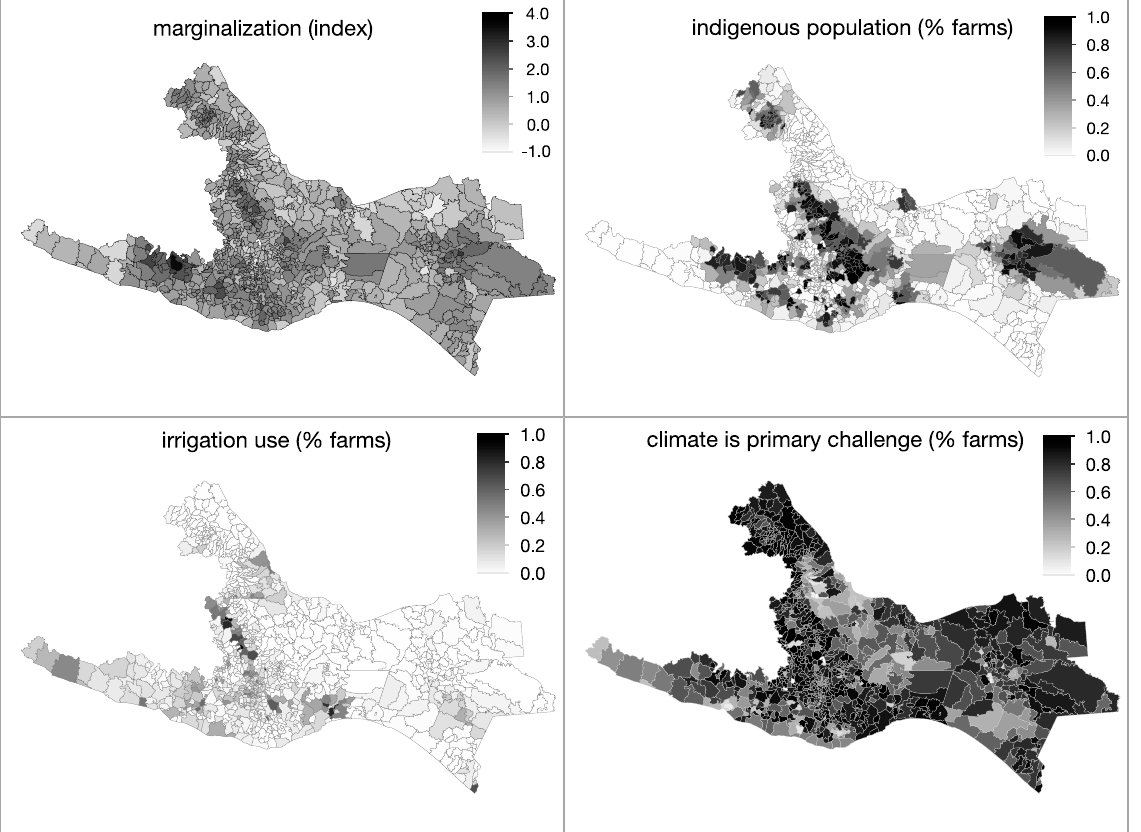
Figure A1. Maps of the four priority indicators by municipalities in the study area.